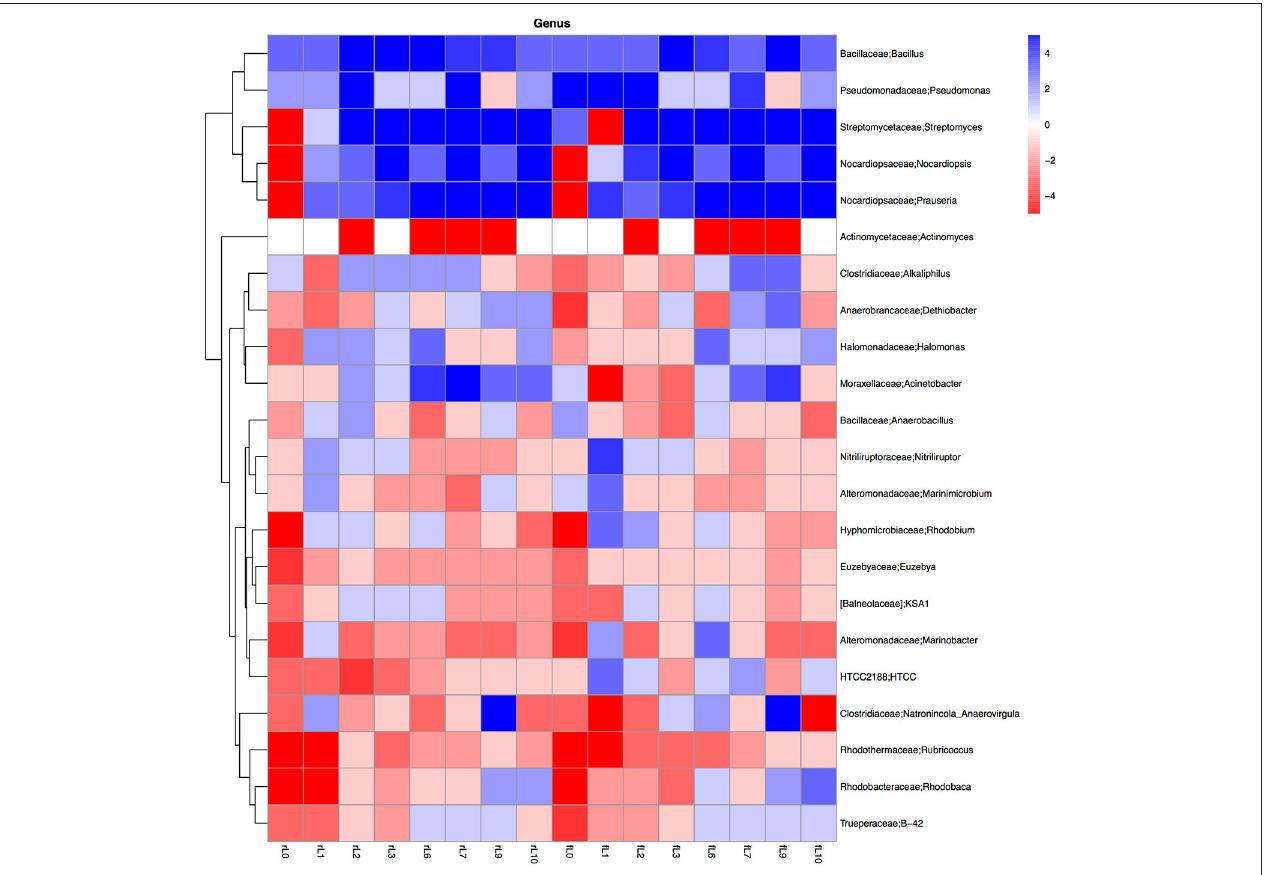
FIGURE 11 | Heatmap of the ratio between the relative abundance of the different bacterial genera in the unamended soil vs. the soil amended with maize plantlets or its neutral detergent fiber (NDF). Legends to the figure can be found in Figure 5 .